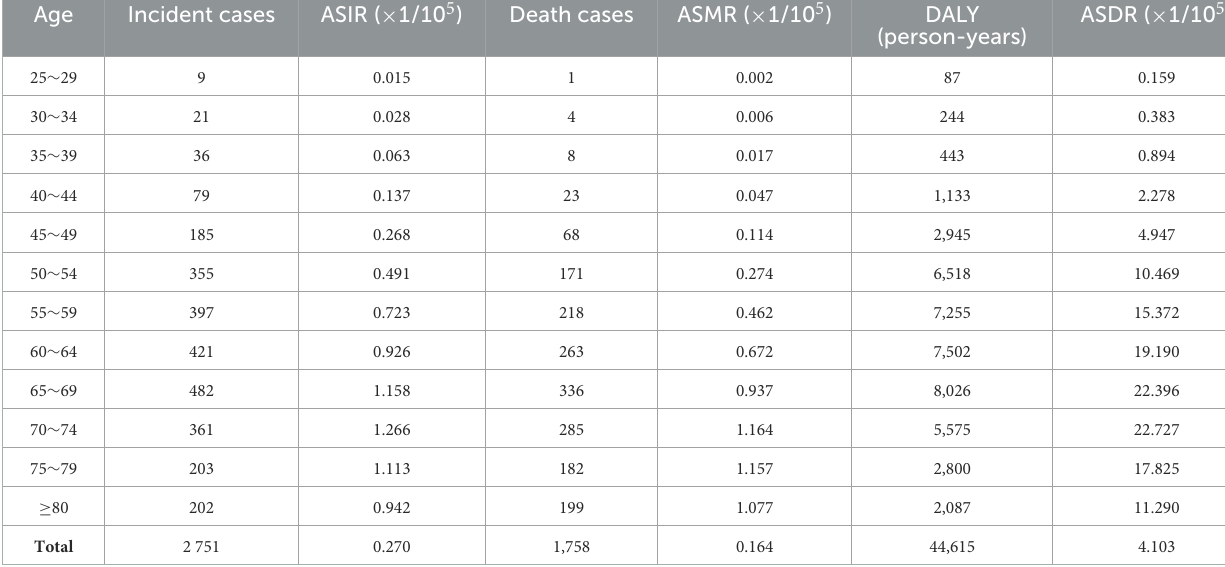
TABLE 4 The age distribution on ASRs of ovarian cancer attributable to hyperglycemia in China,